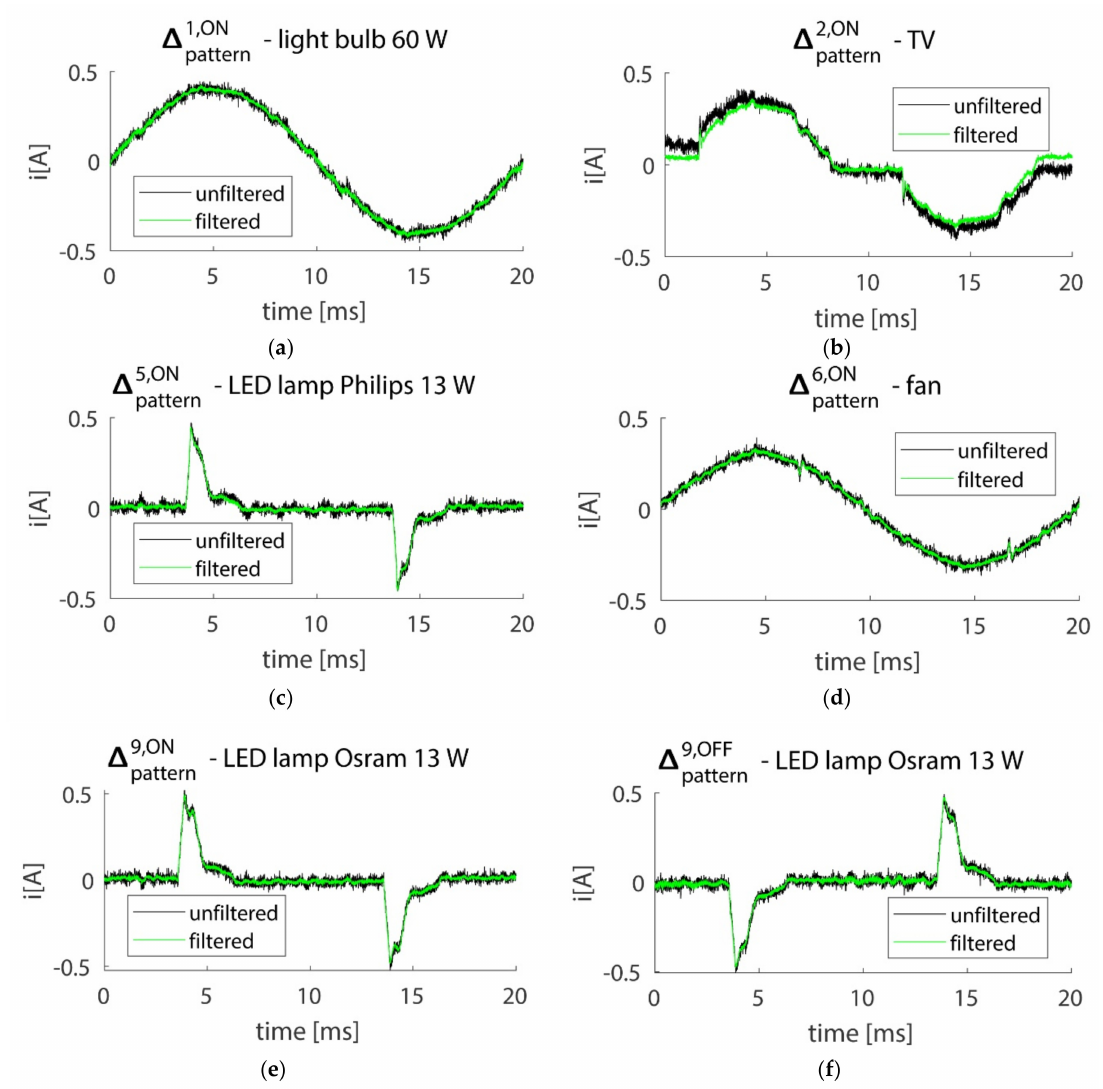
( a , s ) Figure 7. Comparison between sample vectors ∆ I for selected appliances. ( a ) switch ON of the pattern light bulb—AE no. 1, ( b ) switch ON of the TV—AE no. 2, ( c ) switch ON of the led lamp Philips 13W– AE no. 5, ( d ) switch ON of the fan—AE no. 6, ( e ) switch ON of the LED lamp OSRAM—AE no. 9, ( f ) switch OFF of the LED lamp OSRAM—AE no. 9. Filtering allowed for highlighting the signal components’